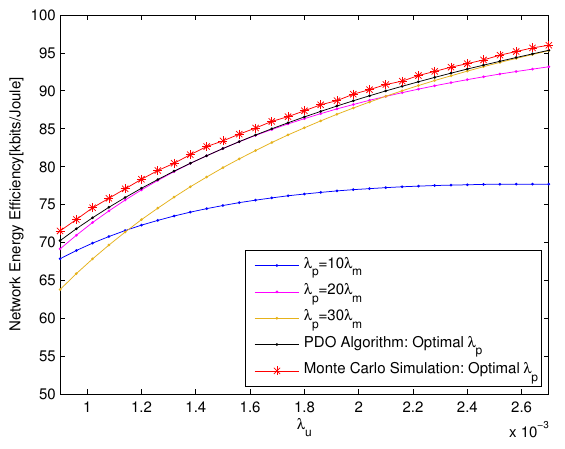
Figure 5. The network EE versus λ u with B p =